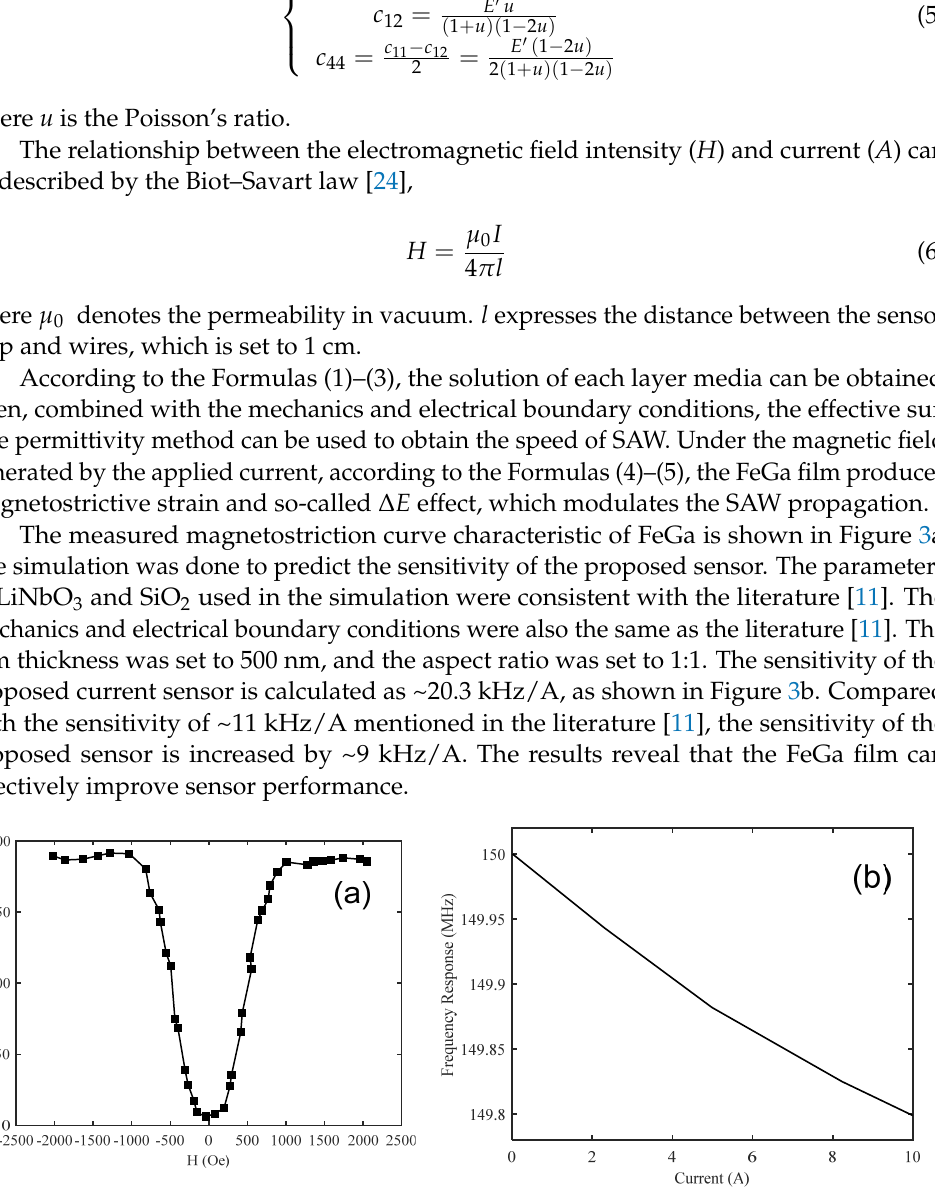
Figure 3. ( a ) The magnetostriction curve characteristic of FeGa; ( b ) the predicted sensitivity of the 150 MHz SAW-based current sensor.